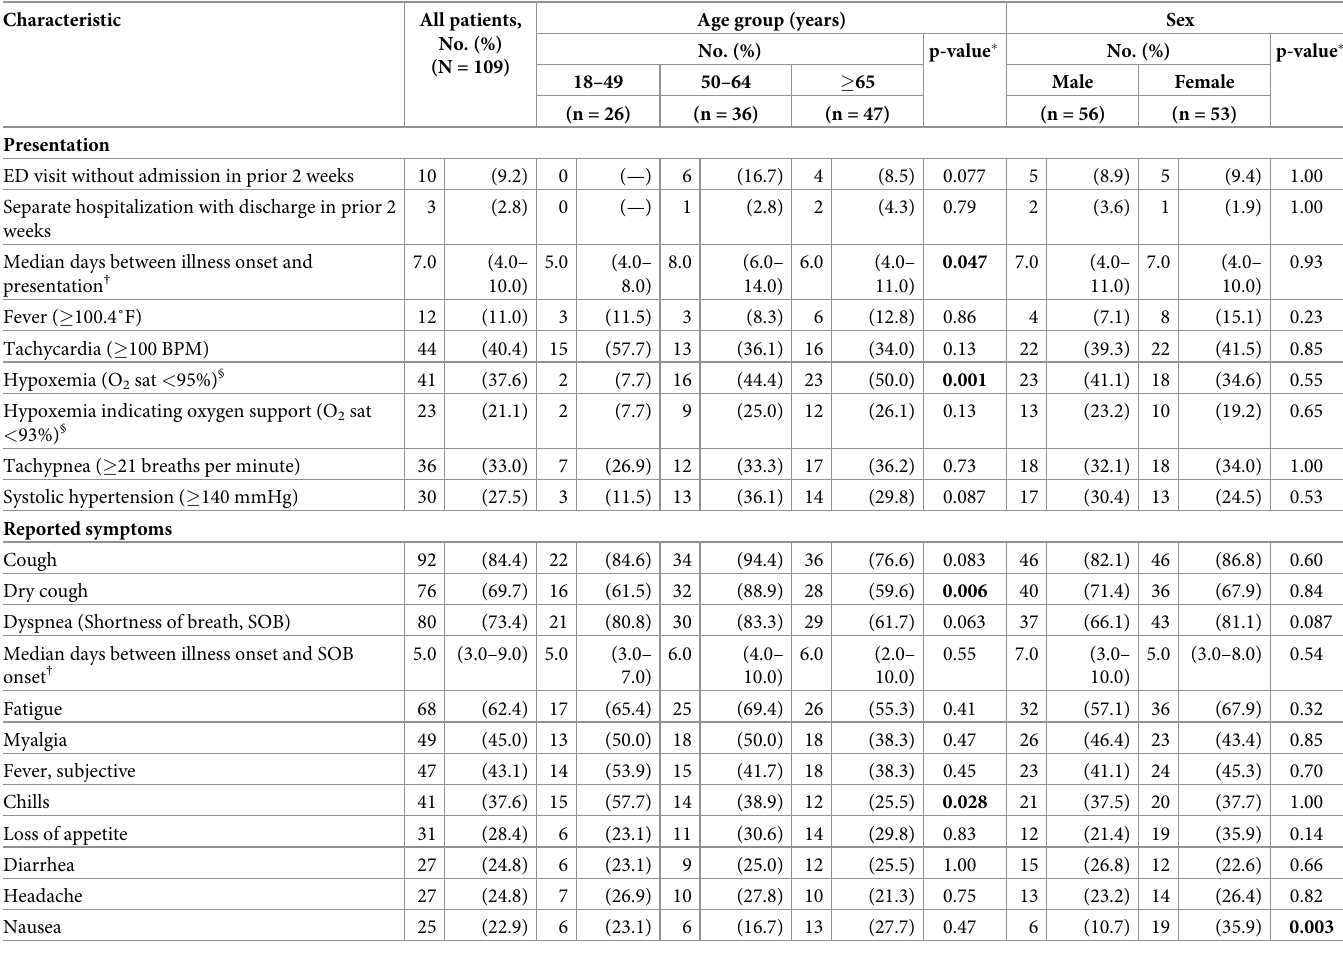
Table 3. Status at presentation and reported symptoms in adults hospitalized with COVID-19 (N = 109), by age group and sex—Puerto Rico, March-August 2020.